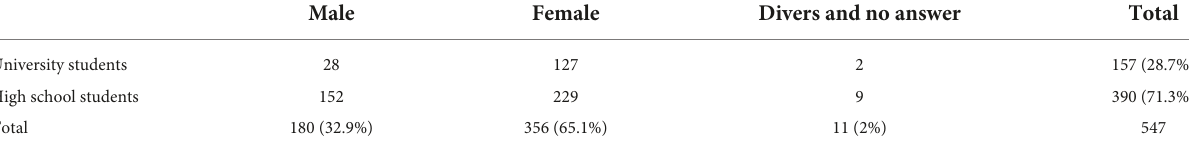
TABLE 3 Gender distribution of sample